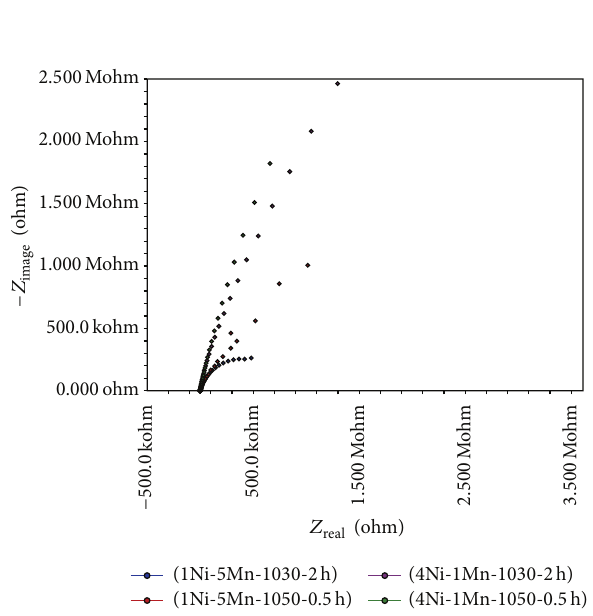
Figure 4: Electrochemical impedance response of the alloys in deaerated 0.5 M NaCl solution at room temperature, 25 ∘